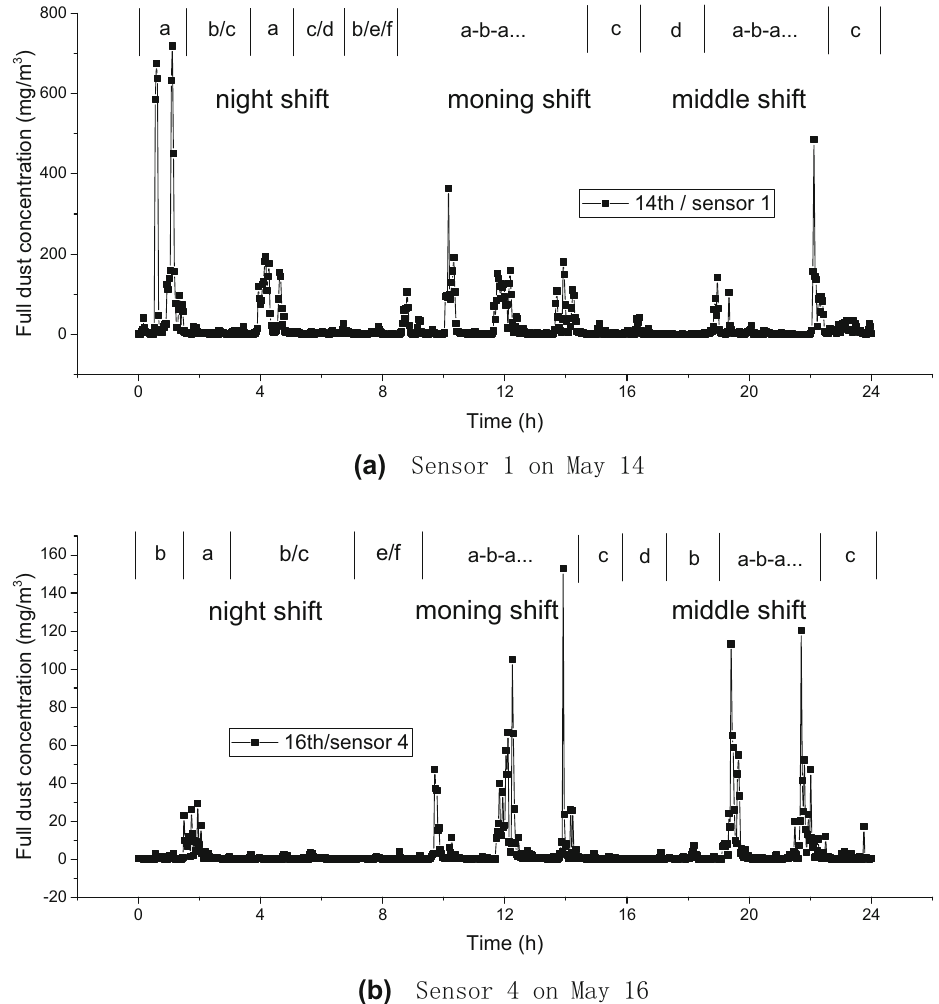
Fig. 7 Single-day total dust concentrations and process control a Mining. b Collecting coal. c Support. d Overhaul. e Shifting machine. f Air